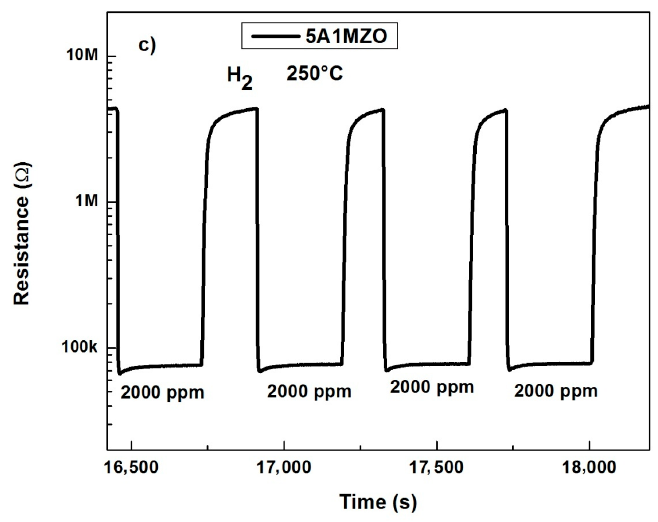
Figure 12. ( a ) Dynamic resistance change of 5A1MZO based sensor toward H 2 gas, ( b ) its corre- sponding calibration curve, and ( c ) its reproducibility.